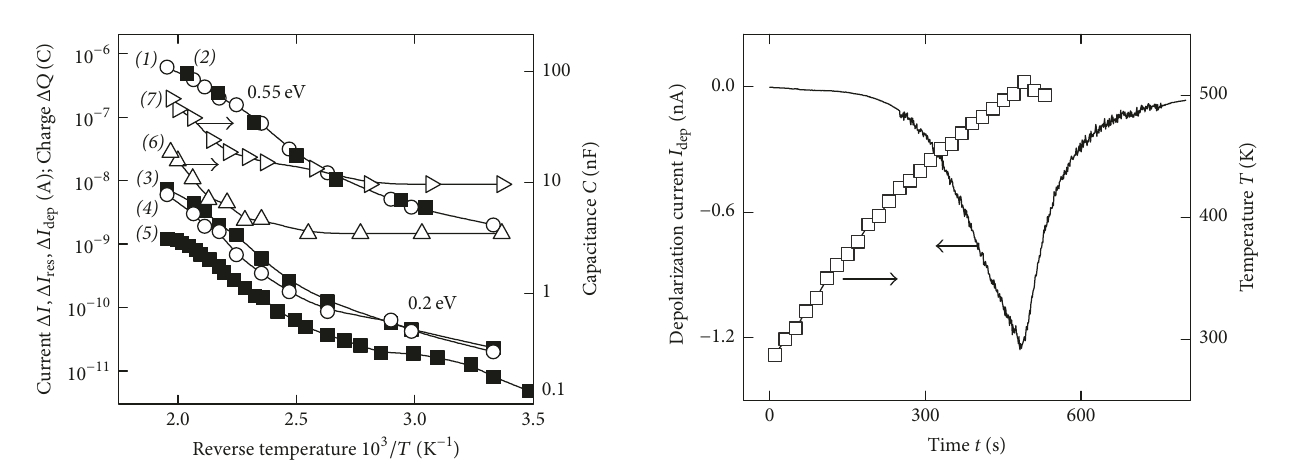
Figure 5: Temperature dependencies of the net charge Δ𝑄 (1, 2) , of the forward current at zero reverse one Δ𝐼 (3), of the residual current Δ𝐼 (4) , of the depolarization current 𝐼 res quasistatic capacitance (6, 7) of the MOM stacks with different YSZ film thicknesses 𝑑 , nm: (1) —15; (2–6) —40, (7) —10.